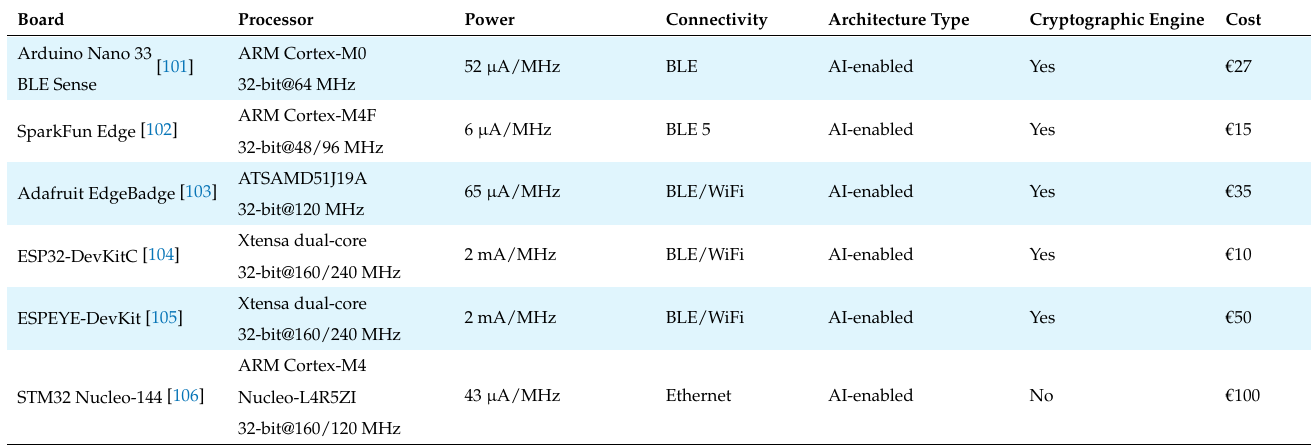
Table 2. AI-enabled IoT hardware compatible with TensorFlow